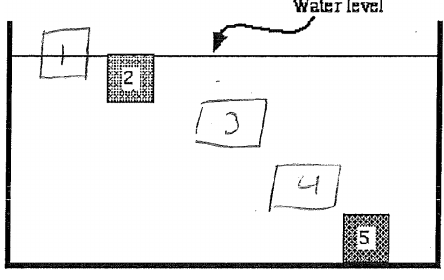
FIG. 4. Incorrect, descending line